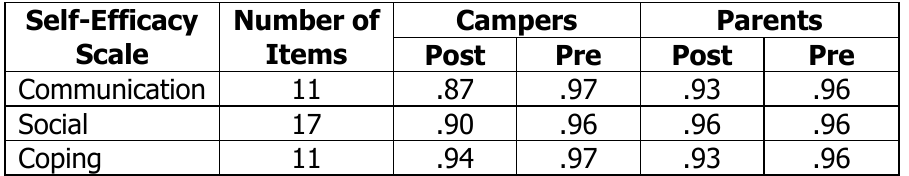
Reliability Coefficients for Self-Efficacy